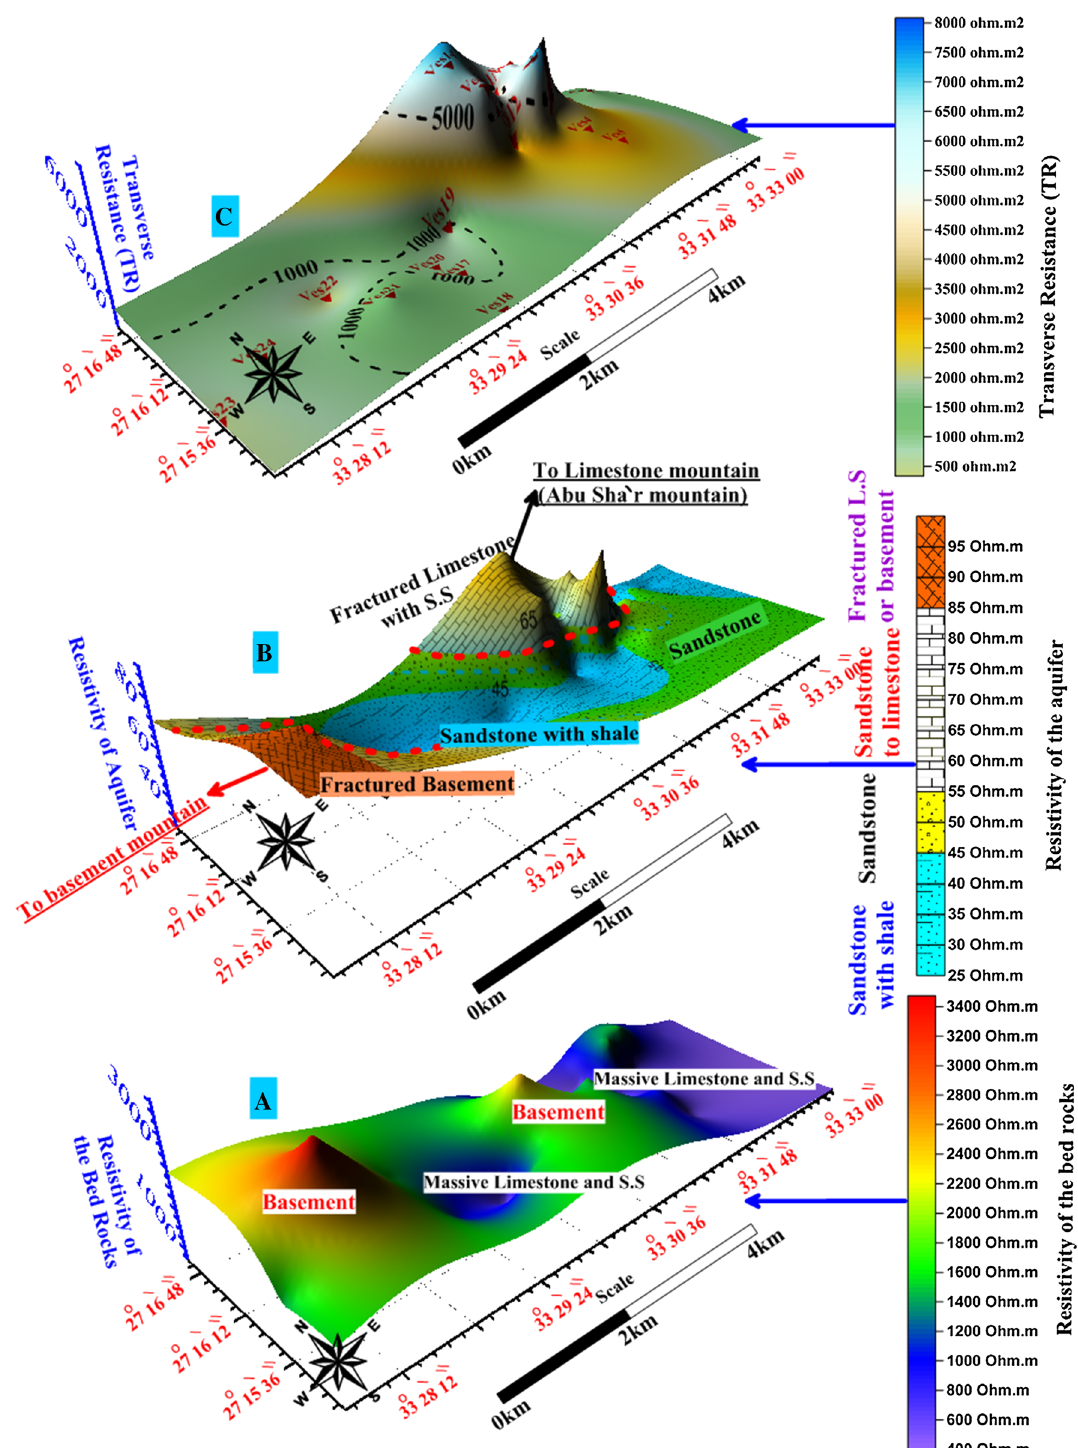
Fig. 8 3-D distribution maps of the resistivity of the bed rocks for showing the relief of the bed rocks ( a ), of the resistivity of the aquifer ( b ) with the distribution of the sediments and rocks, and the transverse resistance of aquifer sediments ( c